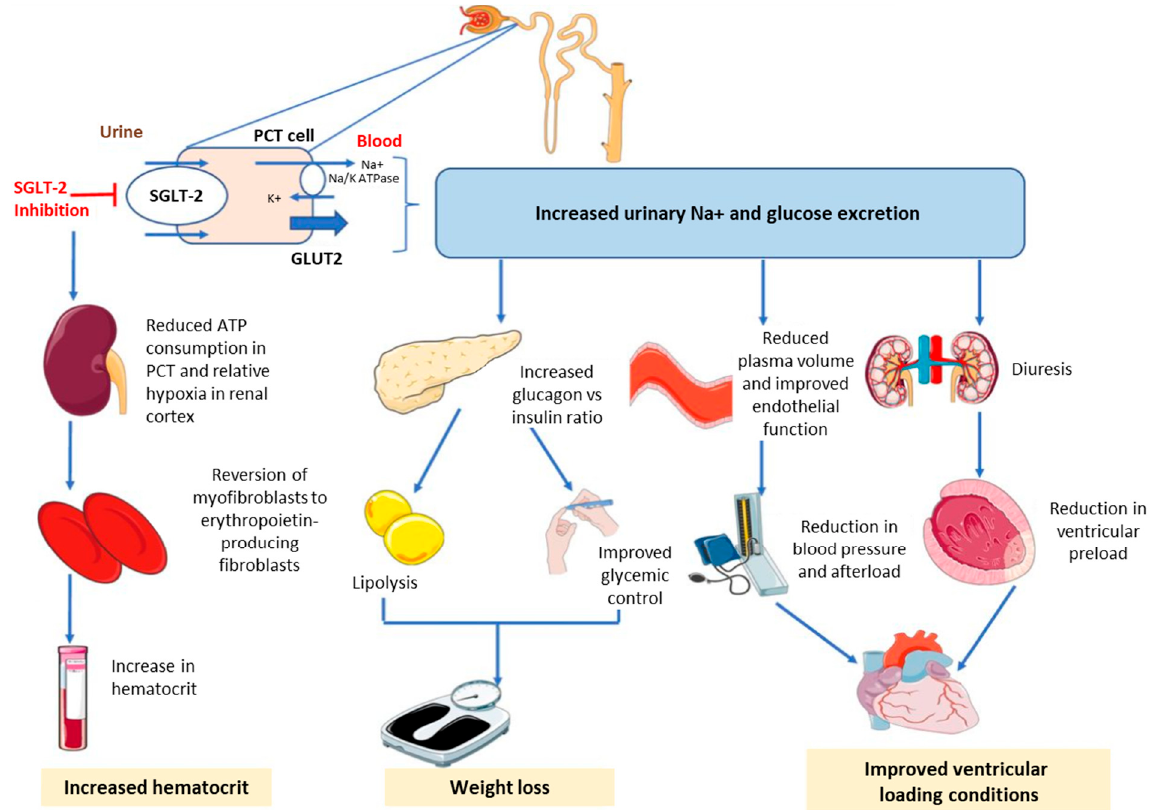
Figure 2. Mechanisms of action of sodium-glucose cotransporter-2 inhibitors. ATP, adenosine triphosphate; GLUT, glucose transporter; K+, potassium; Na+, sodium; PCT, proximal convoluted tubule; SGLT-2, sodium-glucose cotransporter-2. ©2020 S. Joshi. [19] Re-use permitted under CC BY 4.0. Published by BMJ . The original figure published in Joshi et al., was created using Servier Medical Art (http://smart.servier.com).